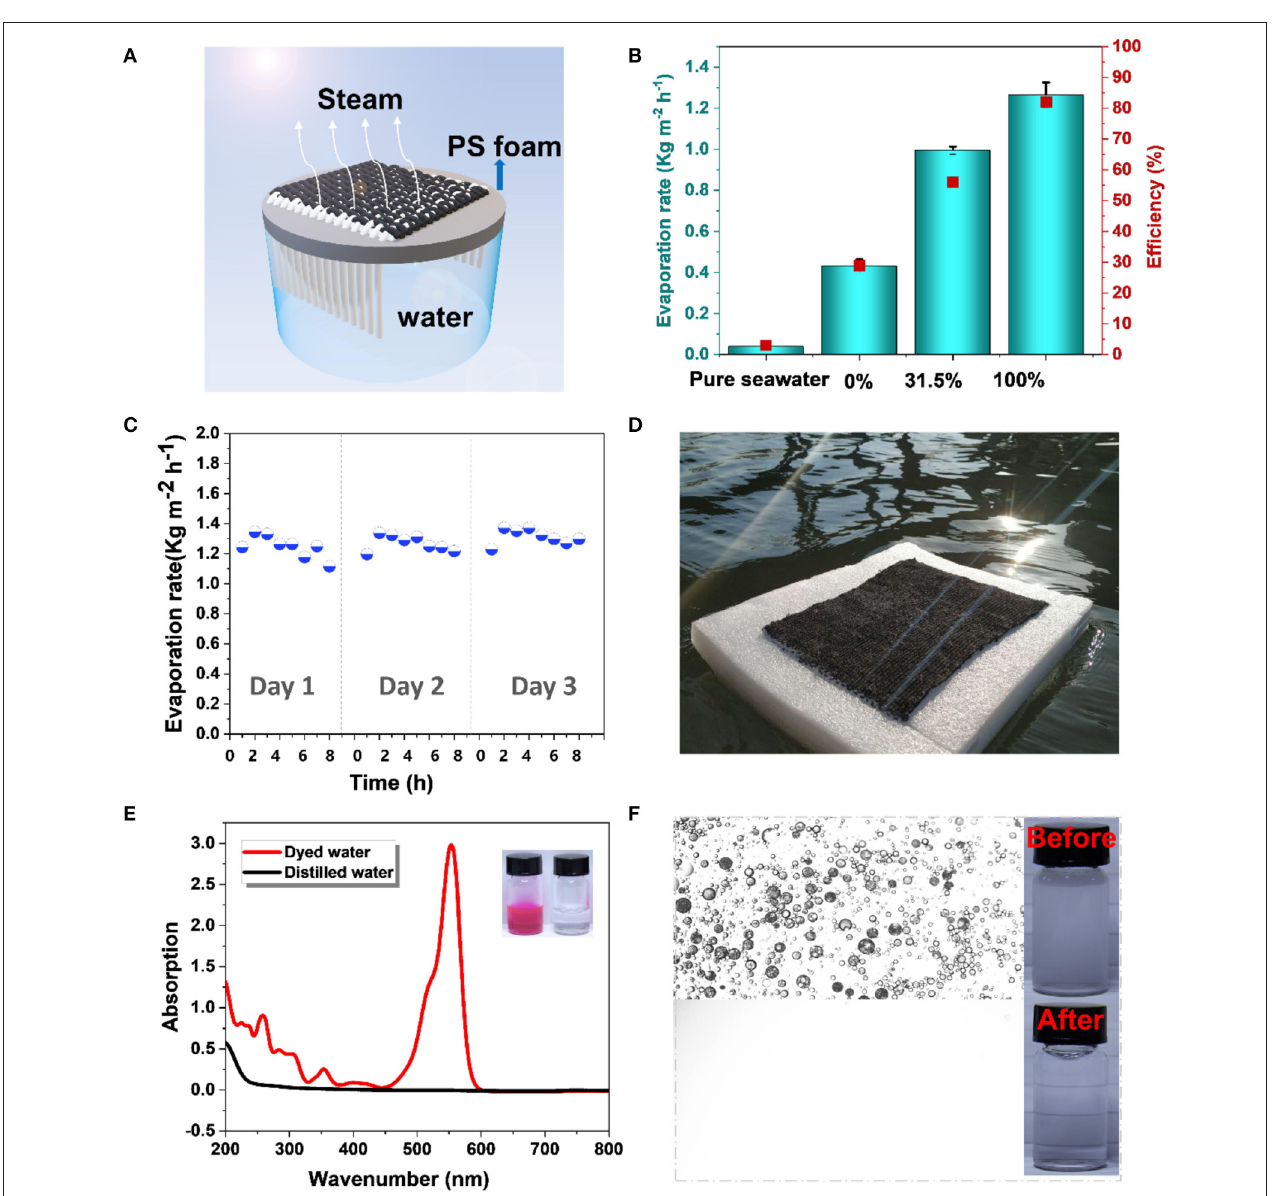
FIGURE 5 | (A) The scheme of an interfacial solar generator; (B) The evaporation rates and conversion efficiency of the simulated seawater without a generator and with generators of different values of CBS coverage at one sun illumination; (C) The evaporation rates of the simulated seawater with a 100% CBS coverage generator for 3 days at one sun illumination; (D) A large-scale 100% CBS coverage generator on the sea; (E) UV-vis absorption spectra and photos of dyed water and distilled water; and (F) Optical microscopic images and photos of oil-in-water emulsion before and after the purification (one sun). solutions is transparent with the purity of 99.99% ( Figure 5E